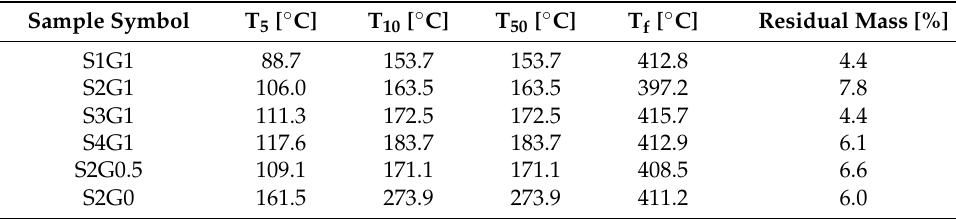
Table 2. Thermal degradation profiles of